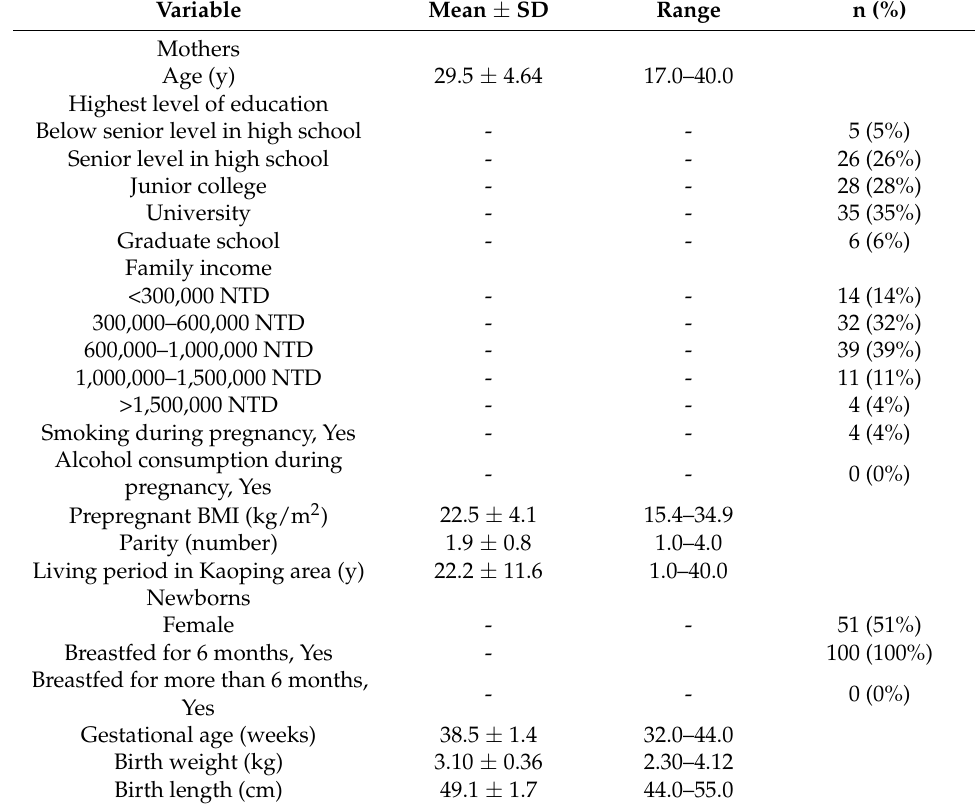
Table 1. Descriptive statistics of the study participant pairs and demographic data of the mothers and newborns (n =